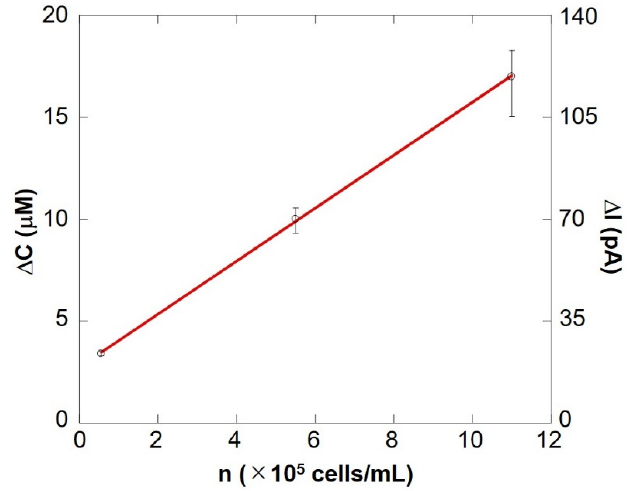
Figure 10. SECM-SCC calibration curve showing cell concentration vs. the change in oxygen concentration. The bar shows the standard deviation of each ∆ I value obtained from multiple scans of SECM-SCC ( n = 3).